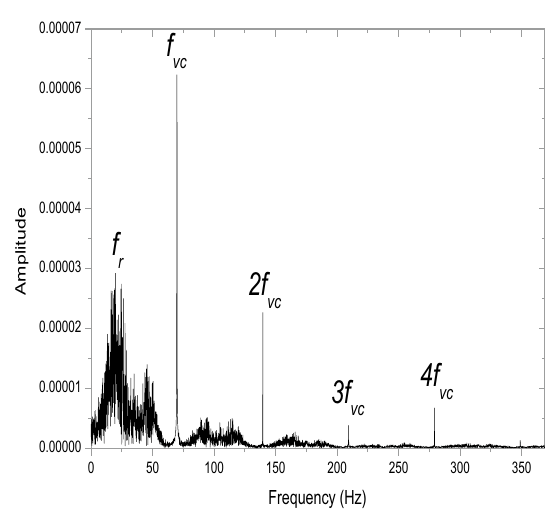
Fig. 6 a Time history; b Spectrum diagram (n = 280 rpm)